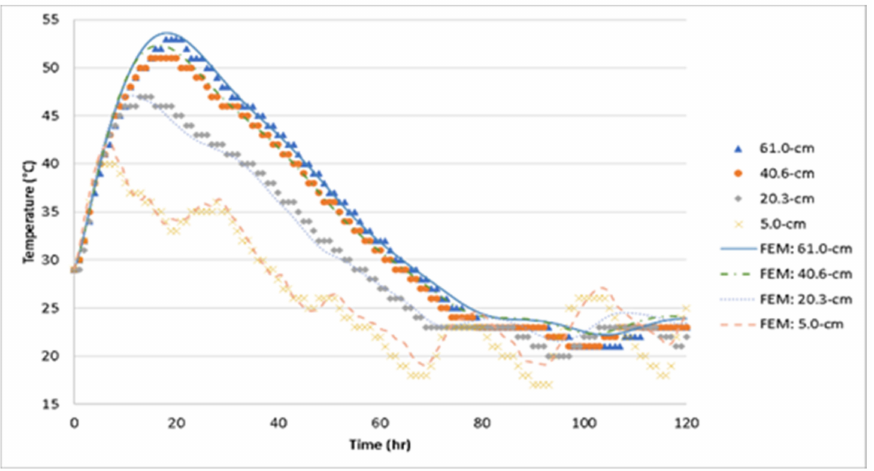
Figure 15. Comparison between FEM model prediction and measured temperatures for Batch 2.